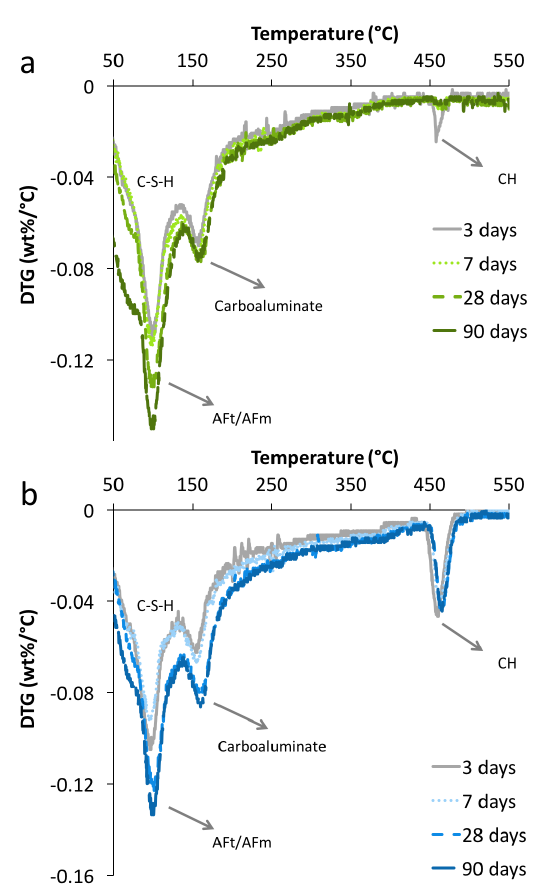
Figure 5. (a) DTG plot for hydrated LC 3 samples at different ages and (b) DTG plot for hydrated SLSC samples at different ages.